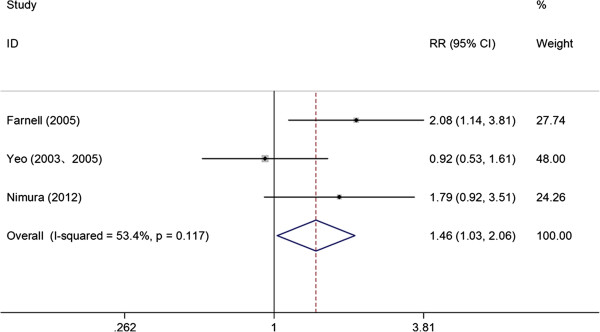
Forest plot for the 3-year survival rate between the pancreatoduodenectomy with extended lymphadenectomy (PD/ELND) group and the standard pancreatoduodenectomy (PD) group. The size of the black box corresponding to each study is proportional to the sample size, and the horizontal line shows the corresponding 95% CI of the relative risk (RR) displayed on the right.